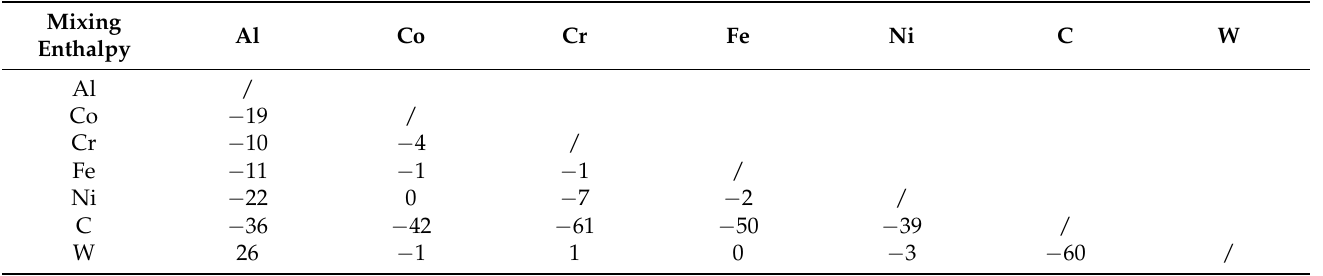
Table 4. Mixing enthalpy between